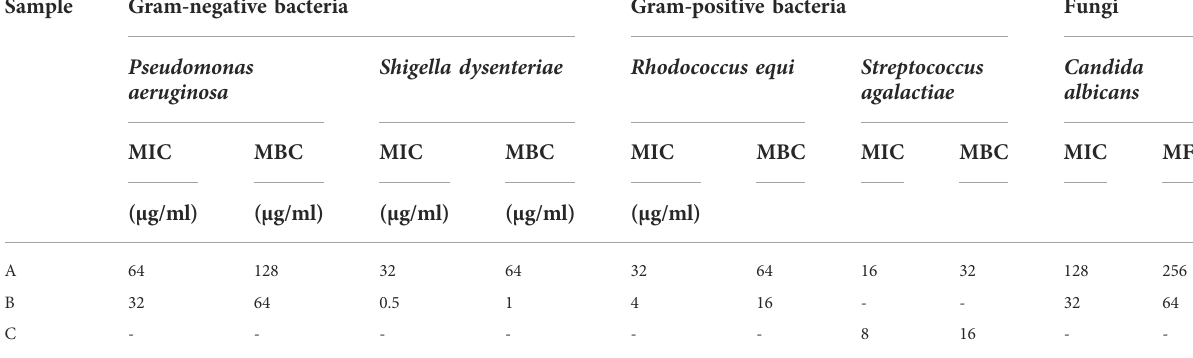
TABLE 1 Antibacterial and Antifungal activity of Fe 3 O 4 /Zn-metal organic framework magnetic nanostructures.